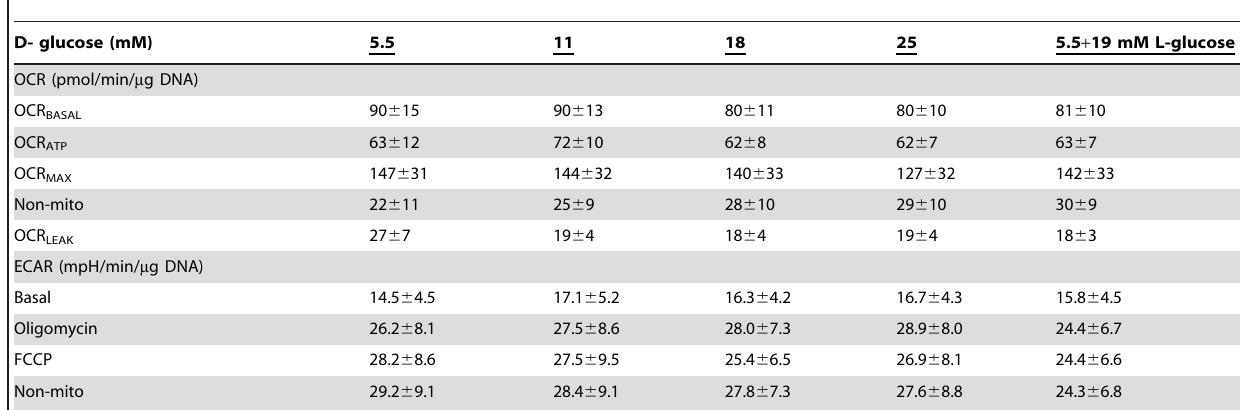
Table 2. Effect of acute exposure to glucose on oxygen consumption rates (OCR) and extracellular acidification rates (ECAR) in BAE cells exposed to concentrations of 5.5 mM to 25 mM for 20 minutes with these concentrations maintained during incubation in the extracellular flux analyzer, n =6 experiments with each individual value representing a mean of 4–5 wells within a single experimental